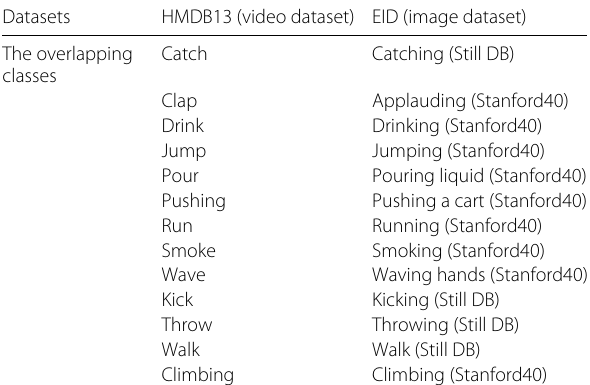
Table 1 The classes of HMDB13 ←